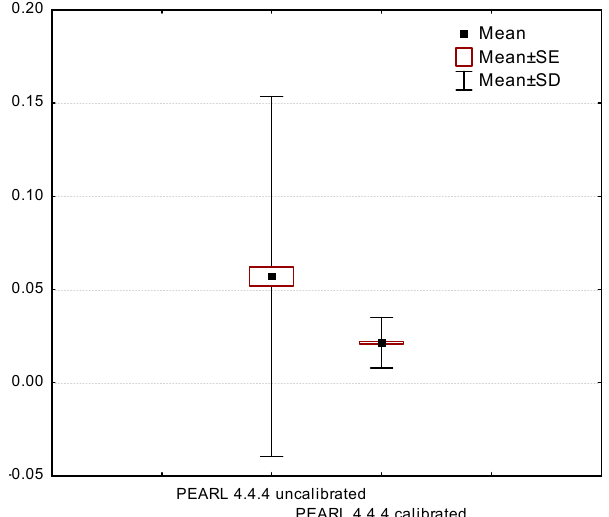
Figure 4. Characteristics of the statistical error distribution in the modeling of the metribuzin concentration in soddy–podzolic soil.